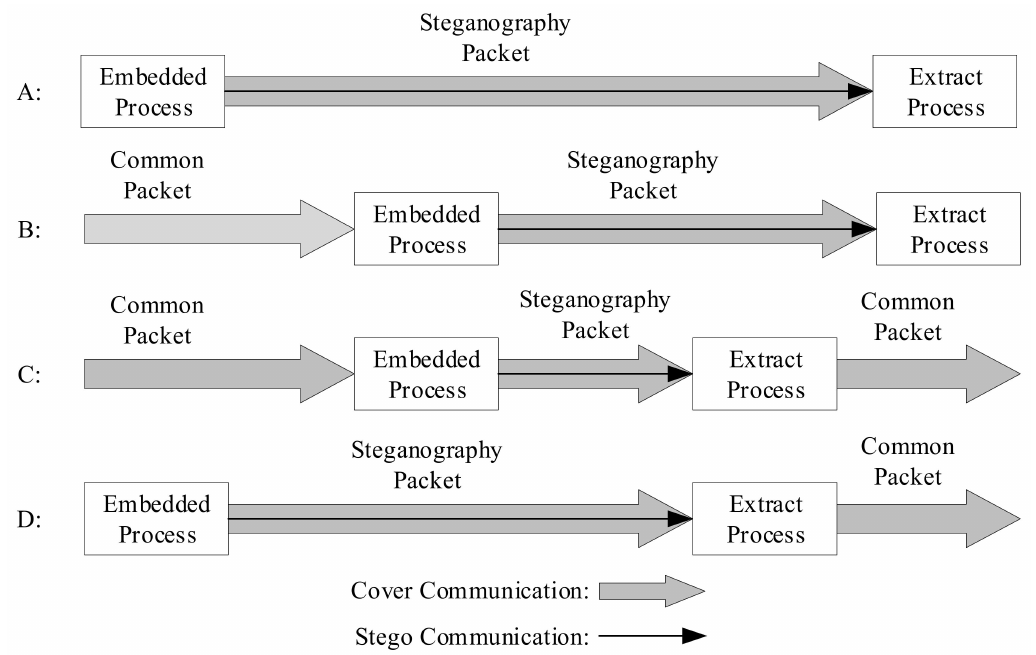
Figure 6. Covert communication scene